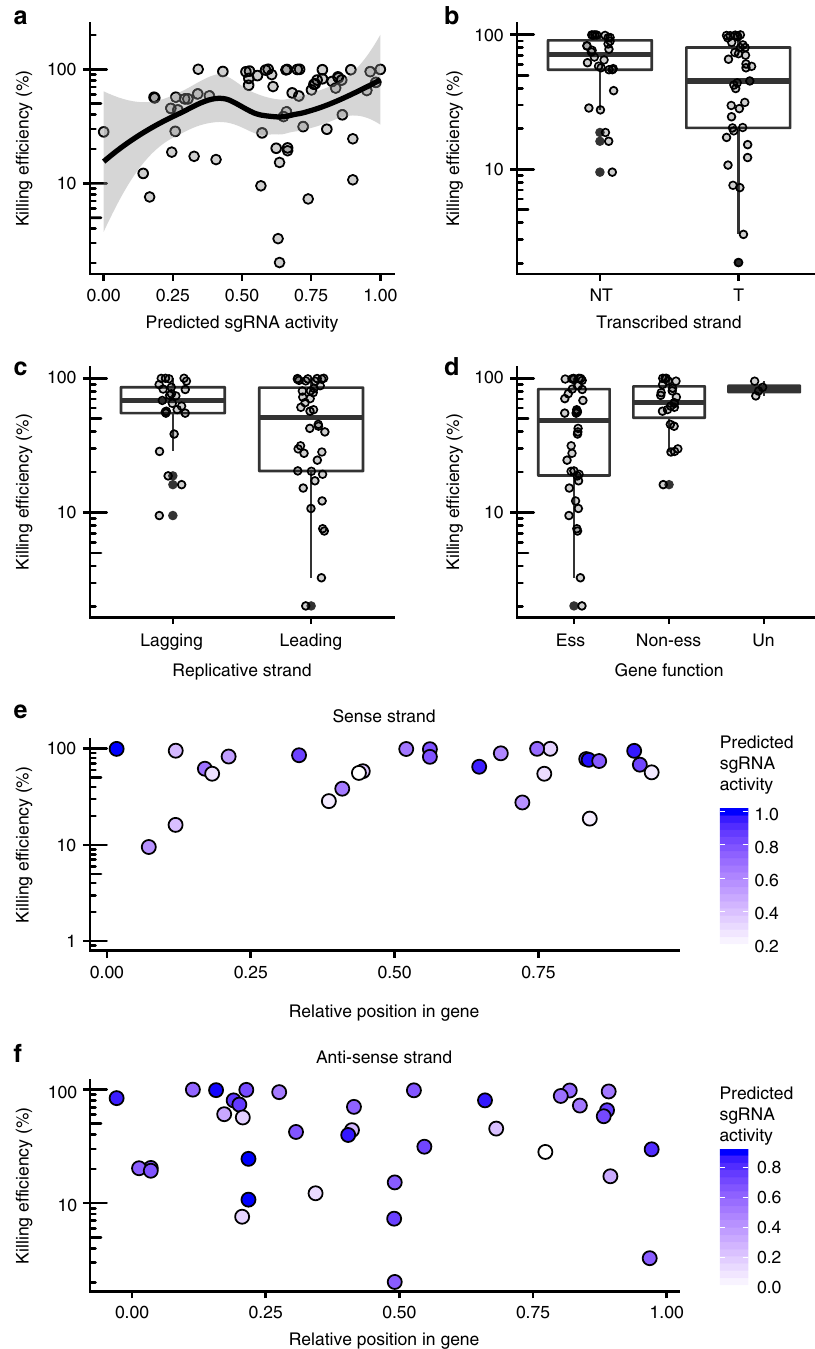
Fig. 4 Effect of sgRNA targeting parameters on killing ef fi ciency. a Plot of predicted sgRNA activity versus S . enterica killing ef fi ciency for all 65 sgRNAs. The shaded area is the 95% con fi dence interval of the line of best fi t. Boxplots of sgRNAs targeting different strands for b transcriptional (S sense strand, AS anti-sense strand) and c replication, and d sgRNAs targeting genes with essential (Ess), nonessential (NEss), or unresolved phenotypes (Un) versus killing ef fi ciency. e Plot of relative position of sgRNAs within genes versus average killing ef fi ciency for the sense strand and f anti-sense strand of targeted genes. For each plot, points are fi lled according to their predicted sgRNA activity. Killing ef fi ciency is plotted on a log10 scale. Source data are provided as a Source Data fi